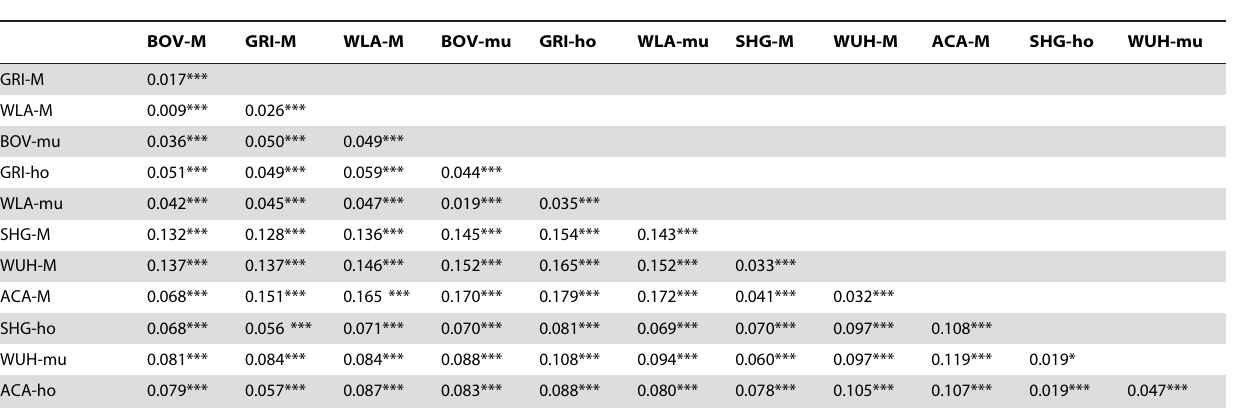
Table 2. Pairwise F ST estimates. Population codes are defined in Table